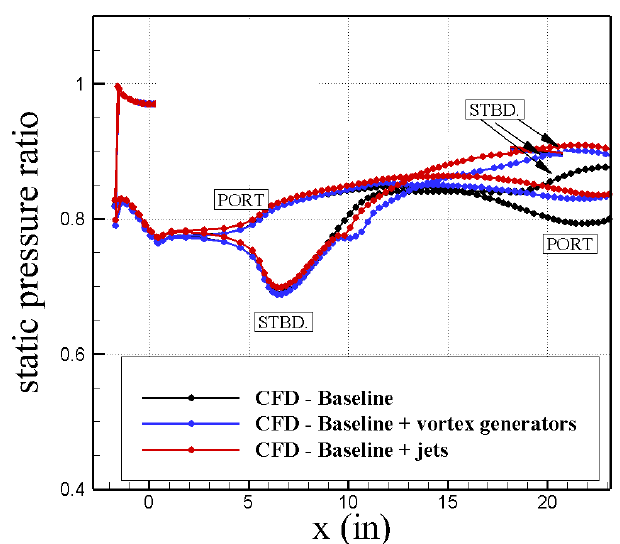
Figure 15. Wall pressure data for the baseline, baseline + vortex generators, and baseline + jets simulations. Static pressure ratio ( p f / p 0 ∞ ) is the ratio of averaged engine face static pressure to free-stream total pressure. USAFA grids and SARC-DDES turbulence models were used. CFD data are time-averaged from 2 to 2.5 s of simulation time.